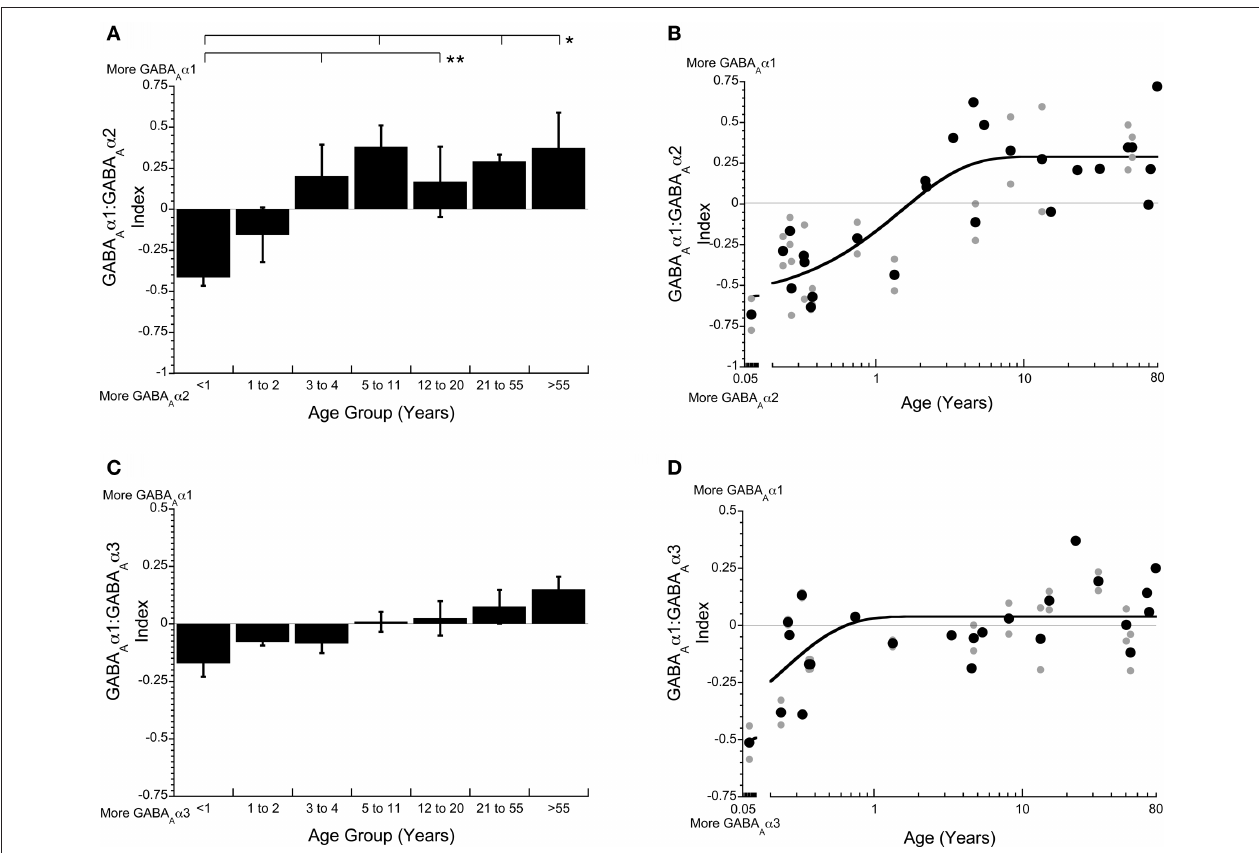
FiGure 5 | The indices of GABA α 1:GABA α 2 (A,B) and A A GABA α 1:GABA α 3 (C,D) are important for determining the kinetics and A A maturation of the GABA receptor. The GABA α 1:GABA α 2 index starts in A A A favor of GABA α 2, then shifts to more GABA α 1 in children (3–4 years), reaching A A the adult balance in younger childhood (3 τ = 4.5 years of age, τ = 1.50 years, R = 0.84; p < 0.0001; B ). The GABA α 1: GABA α 3 index starts out with more A A